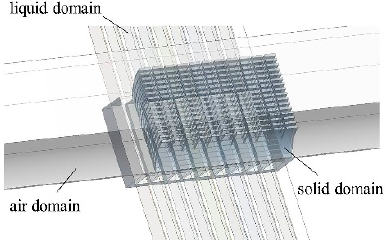
Figure 5. HTU computational domains.